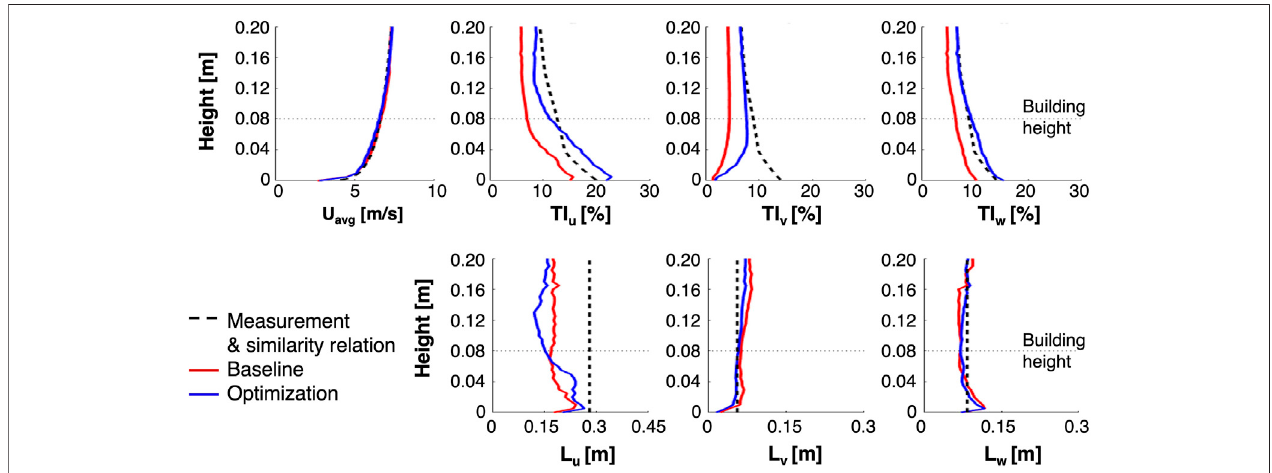
FIGURE2| Meanvelocity,turbulenceintensity,andlengthscalepro fi les:targetpro fi les(blackdashedline),pro fi lesobtainedatthebuildinglocationusingthetarget pro fi les at the in fl ow (red solid line), pro fi les obtained at the building location using the optimized in fl ow pro fi les (blue solid line).